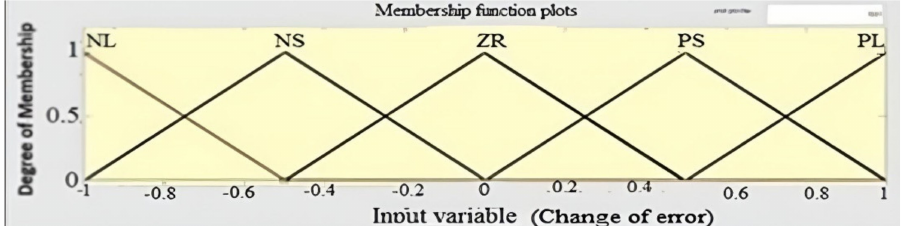
Figure 3. Direct and quadrature current error ( ∆ Id and ∆ Iq). Membership functions for the fuzzy-PI inverter control.